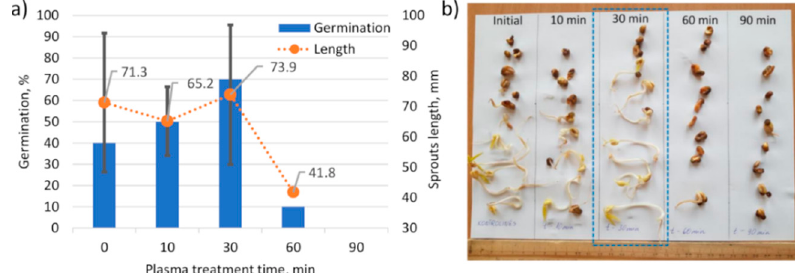
Figure 7. Mung bean germination: ( a ) Germination percentage with sprouts length averages and ( b ) real sprouts images of initial and plasma-treated seeds. Black vertical lines in ( a )—errors presented as standard deviation.